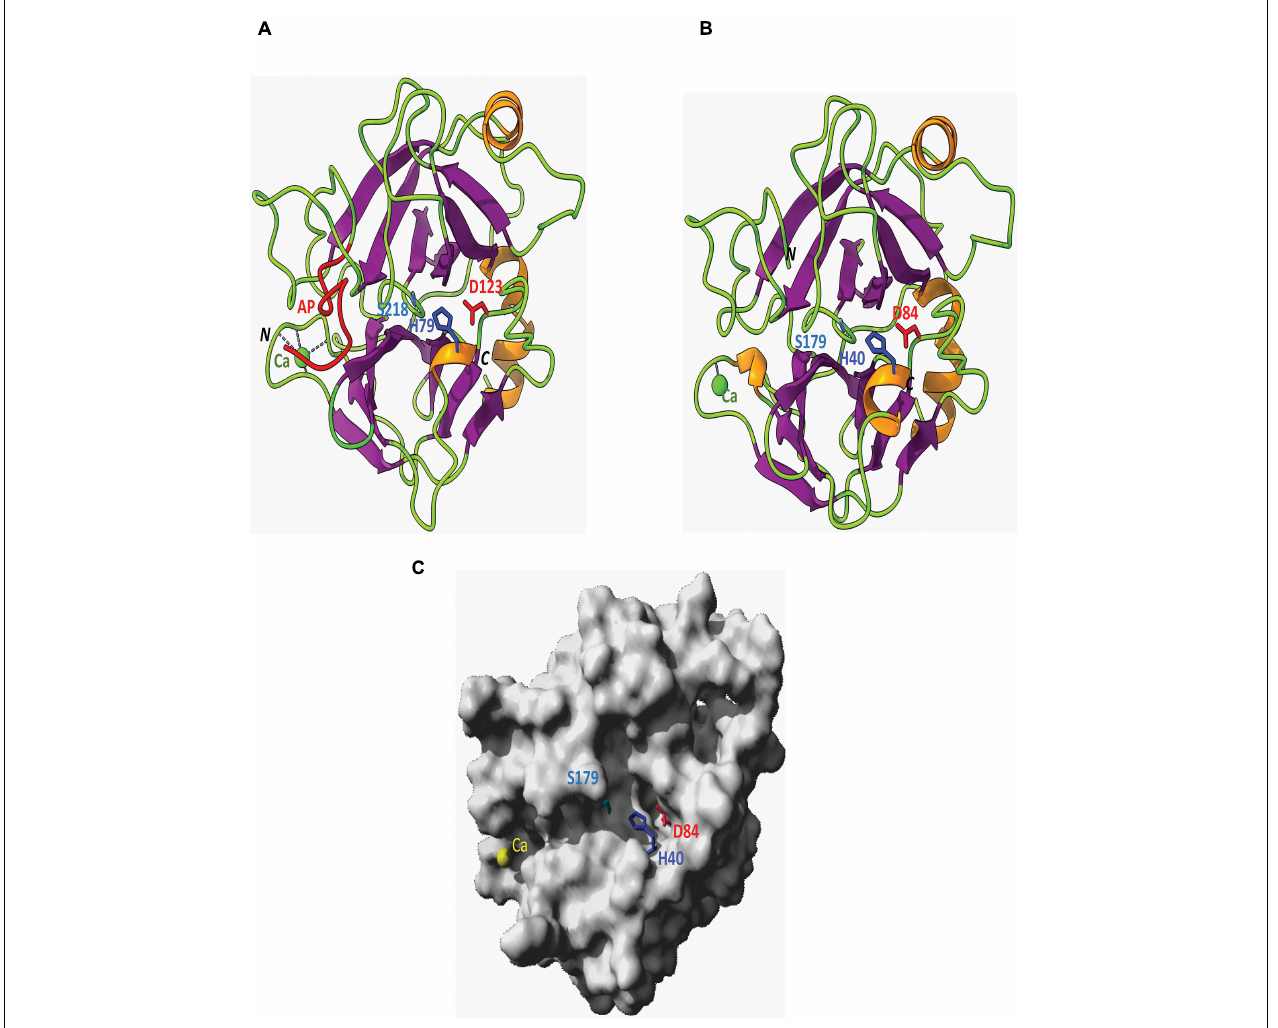
FIGURE 6 | Ribbon-drawn diagrams showing the organization C. quinquefasciatus late trypsin. (A) Pro-trypsin in two domains delineating a central groove that contains the catalytic triad H79, D123, and S218 of the enzyme. The C-terminal part of the activation peptide (AP) is colored red and the coordinated Ca 2 + is colored green. (B) Ribbon diagram showing the organization of the mature trypsin with the catalytic triad H40, D84, and S179 of the enzyme. The N (N) and C (C) terminals of the pro-trypsin and mature trypsin are shown. (C) Molecular surface of the mature trypsin showing the central groove containing the enzyme catalytic triad H40, D84, and S179. The model is similarly oriented as in (B) and the coordinated Ca 2 + is colored yellow.